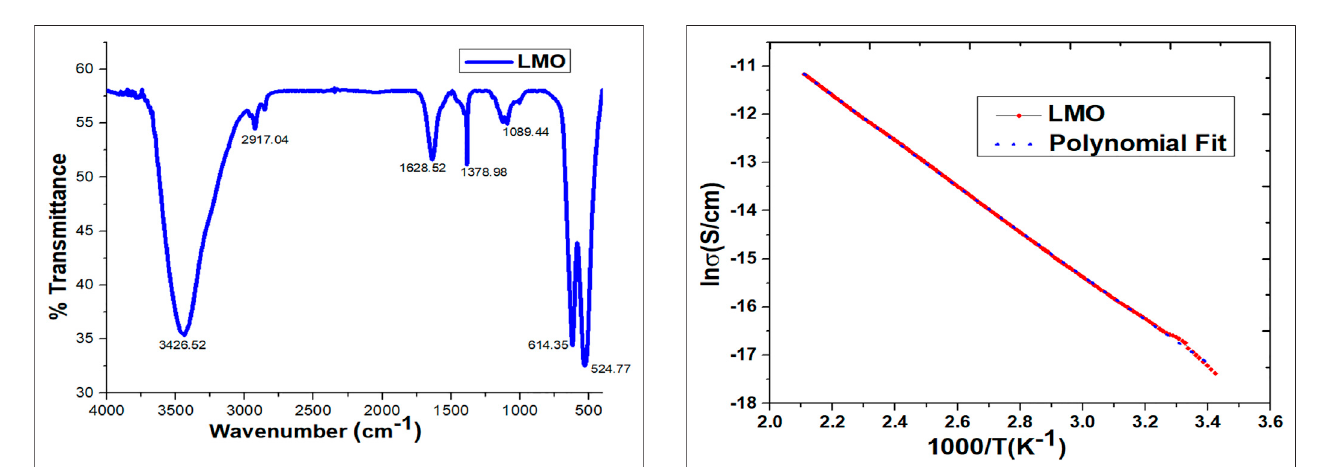
FIGURE 5 | Ionic conductivity measurement of the synthesized LMO sample.